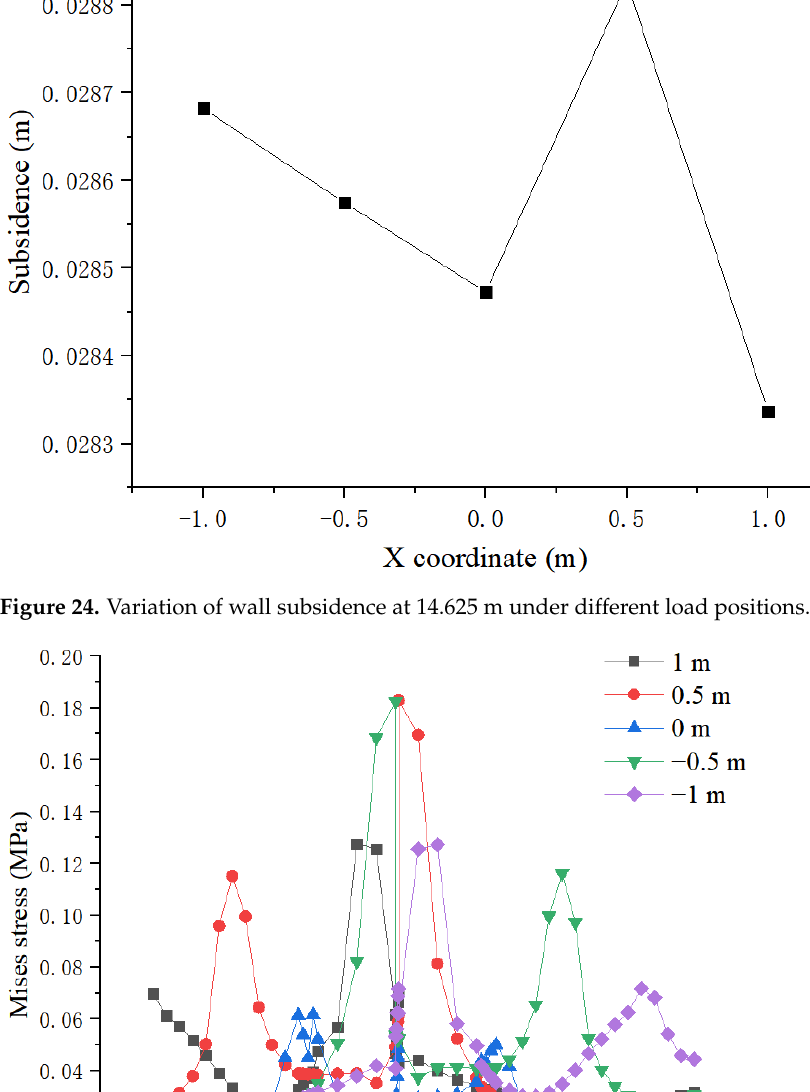
Figure 23. Distribution of dam subsidence at 14.625 m under different load positions.